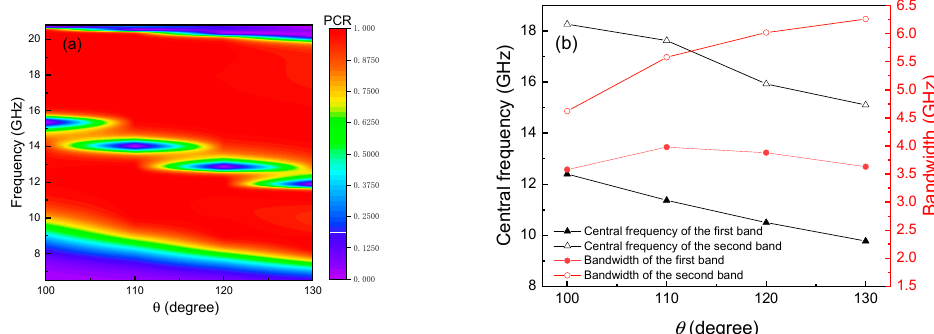
Figure 8. ( a ) PCRs with various values of θ . ( b ) The central frequencies and bandwidths of the two bands corresponding to different values of θ .